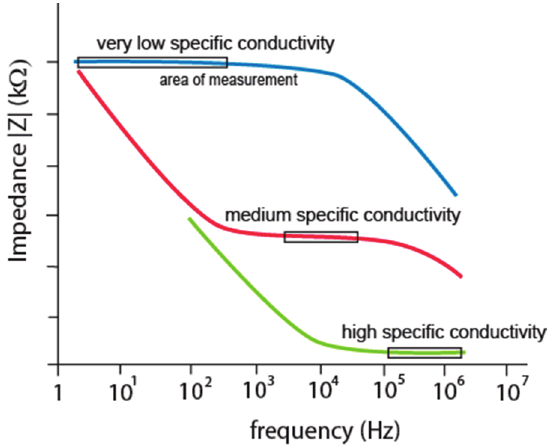
Figure 3. Impedance characteristics of IDEs according to different measured specific